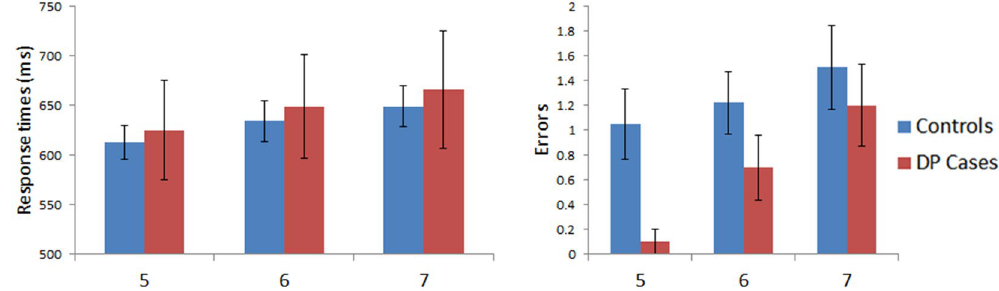
Figure 4. Results for Reading Aloud: Length (sum confusability maintained across words). Data are shown in left panel (response time) and right panel (number of errors) for control and DP groups. Error bars show ± SEM. The three conditions are words comprised of 5-, 6-, or 7-letters with sum confusability controlled for across all words.